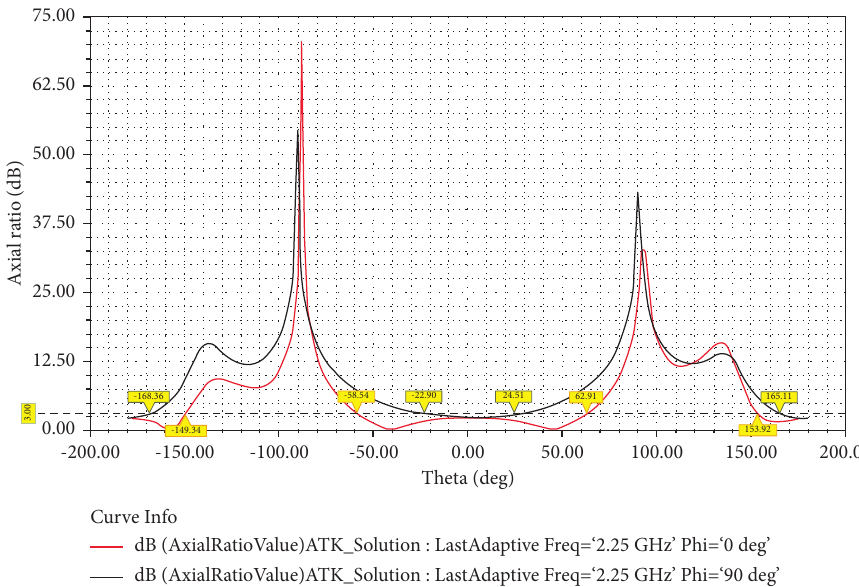
Figure 14: Simulated axial ratio of the optimized antenna as function of angular